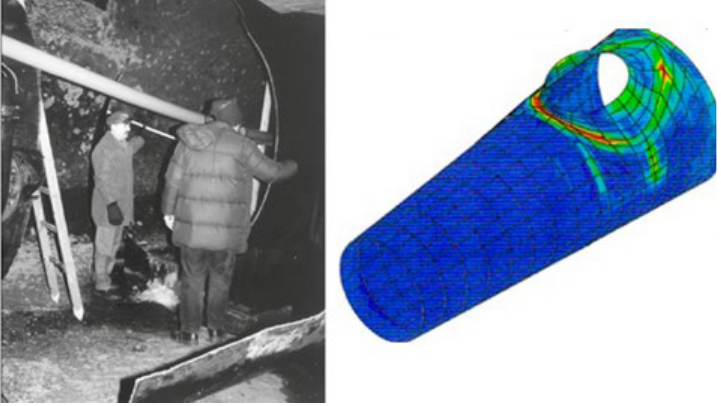
Figure 12. Penstock failure at Lapino HPP in 1997 in Poland [94,95 ].